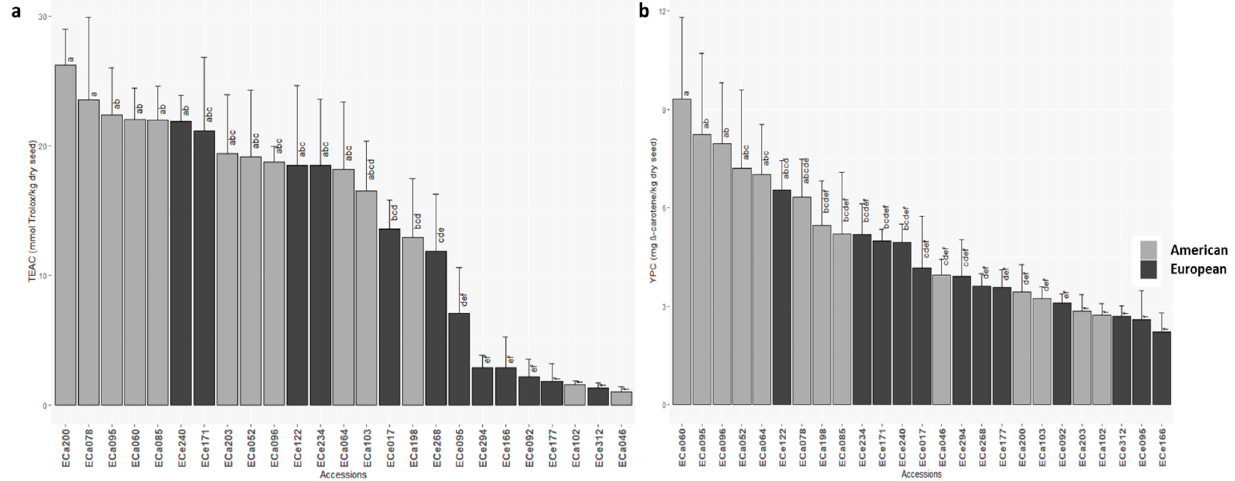
Figure 3. Mean antioxidant activity (TEAC) ( a ) and carotenoids content (YPC); ( b ) for the 25 American and European accessions. Columns with different letters are significantly different ( p < 0.05; Tukey tests).